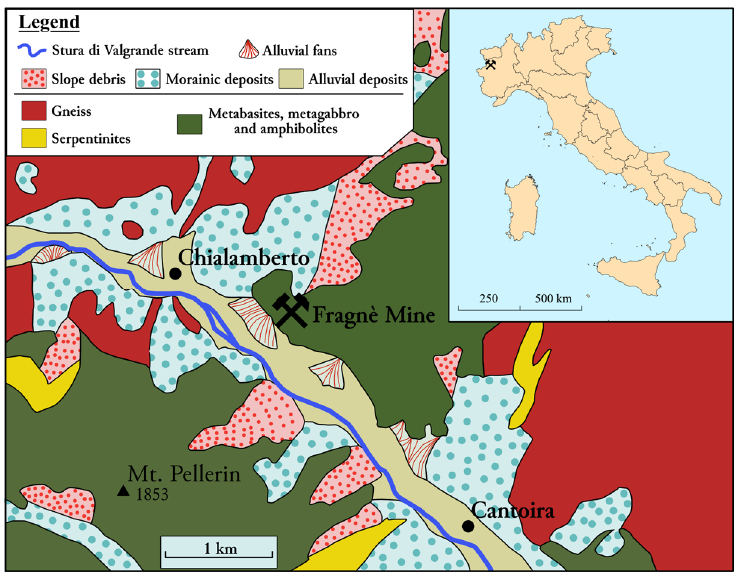
Figure 1. Geographical and geological sketch map of the Fragnè mine (Lanzo Valley, Western Alps). Modified after Foglio 41 Gran Paradiso (http://sgi.isprambiente.it (accessed on 22 June 2022)).